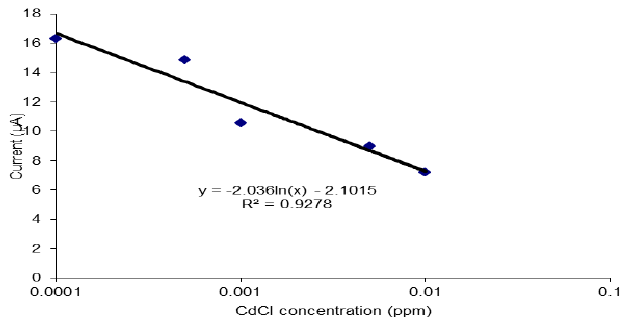
Figure 8. The performance of the biosensor on cadmium chloride (CdCl 2 ).